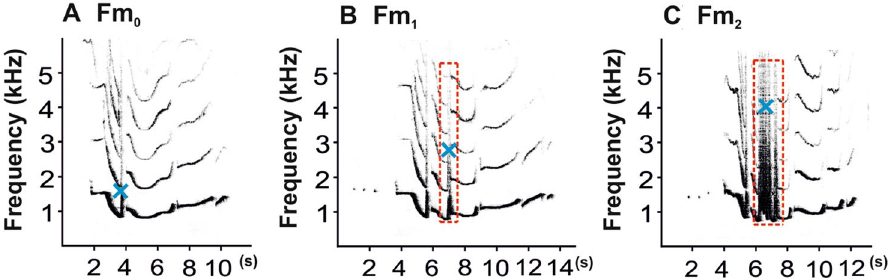
Figure 3. Representative spectrograms show three ( A-C ) different forms of the multi-modulation phrase in young males according to the number of frequency modulations (Fm 0-2 ) in the second note (red dashed rectangle), with or without staccato notes during male vocal development. Blue crosses indicate maximum